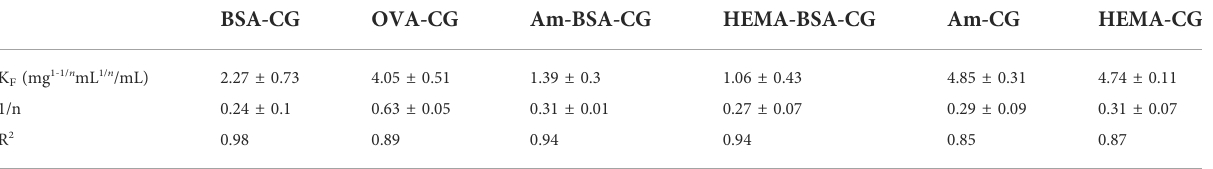
TABLE 3 The Freundlich adsorption isotherm for haemin adsorption on different types of protein